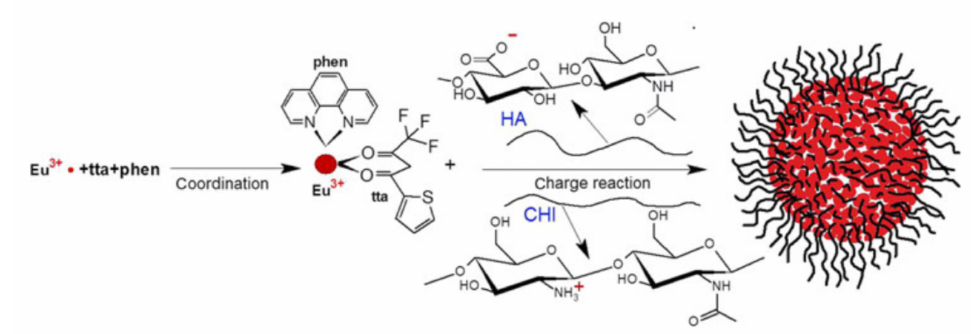
Figure 11. Formation of polyelectrolyte complexes containing Eu 3+ -tta-phen (phenantroline) and stabilized by hyaluronic acid and chitosan. Reproduced from Ref. [98] with permission from the Springer Nature.